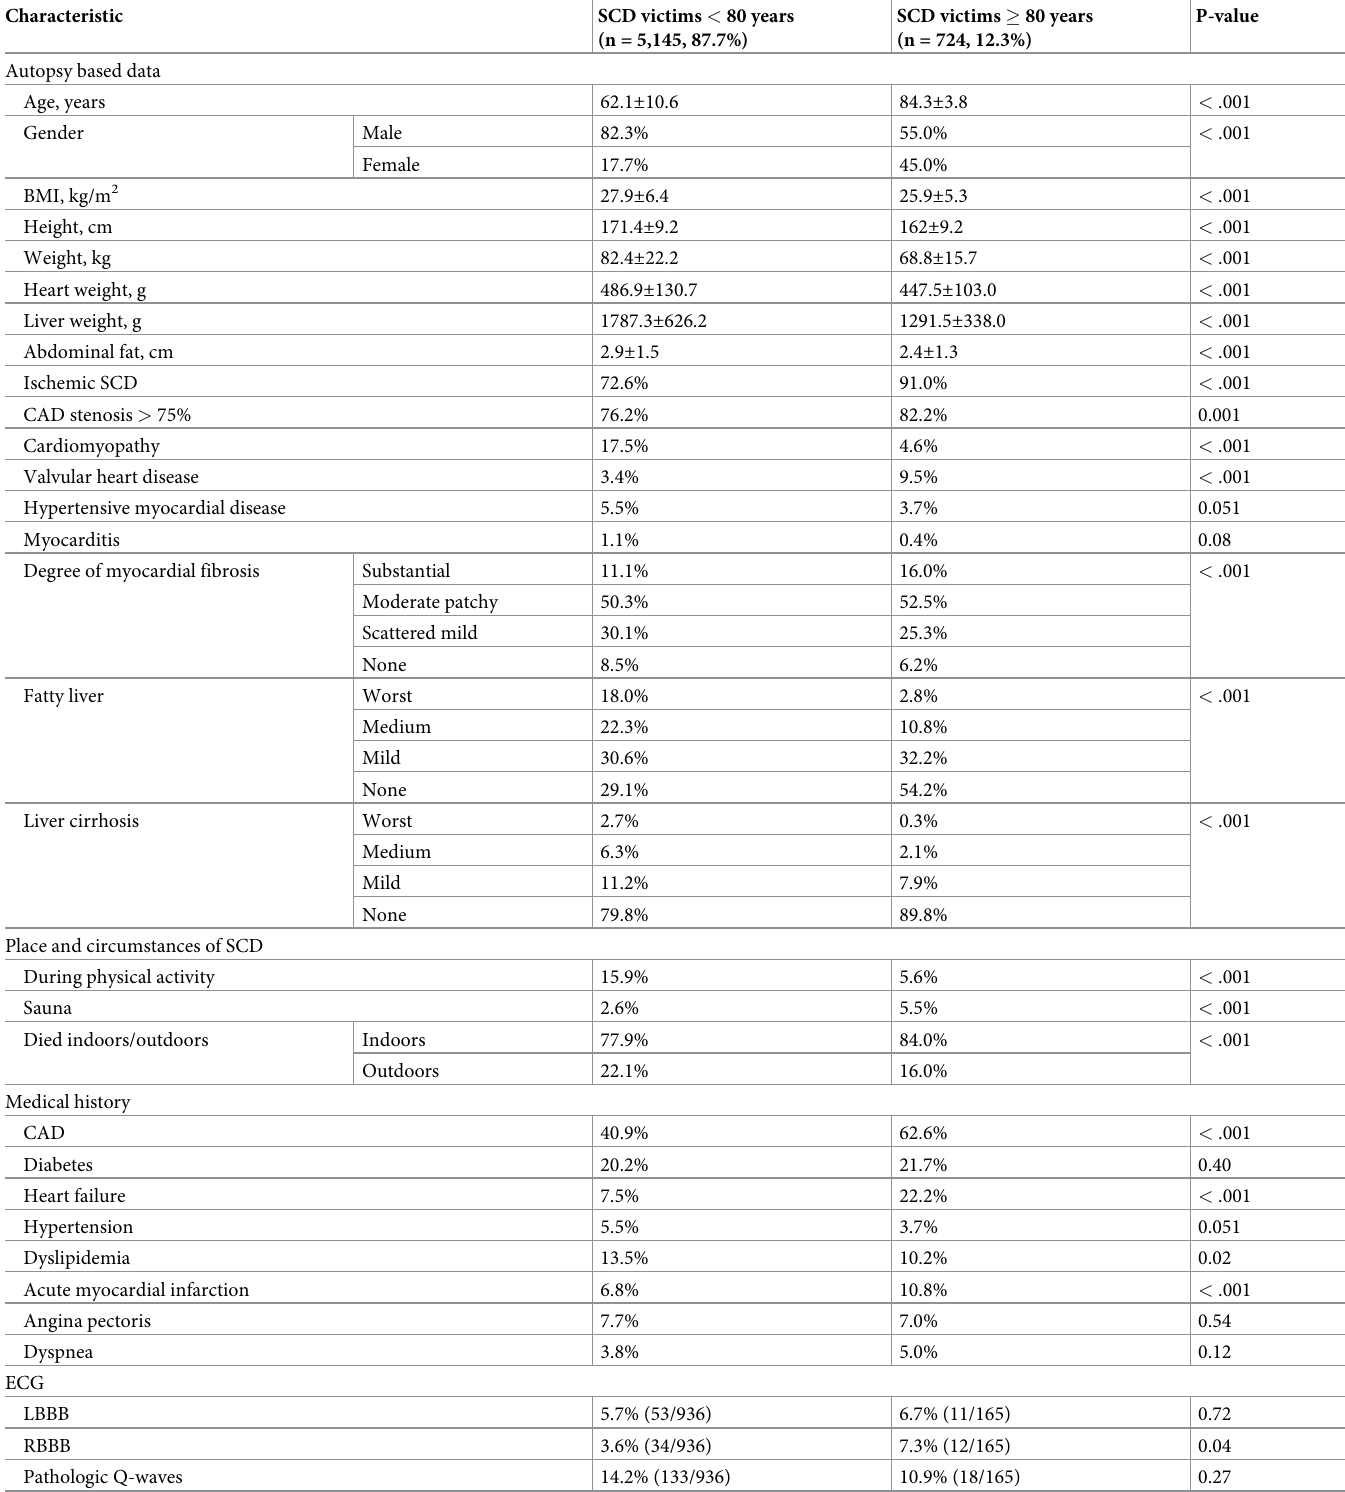
Table 1. Characteristics of sudden cardiac death